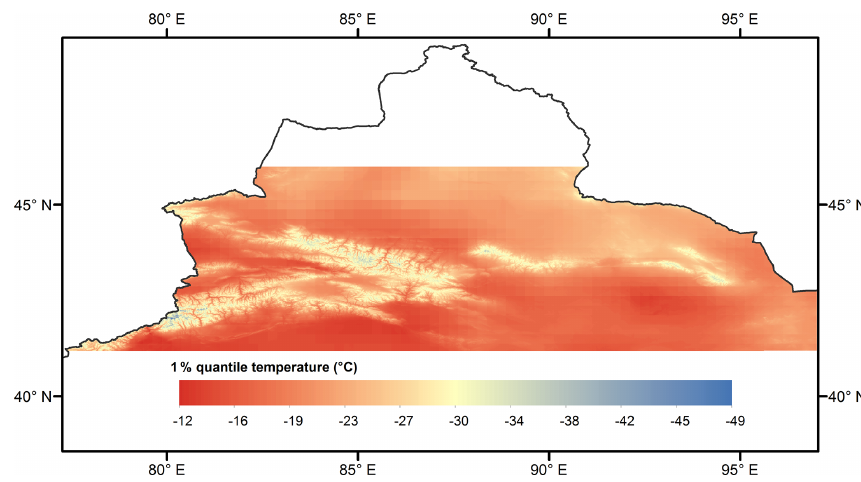
Figure 6. The 1% quantile temperature of the entire CTM based on the high-resolution data set.